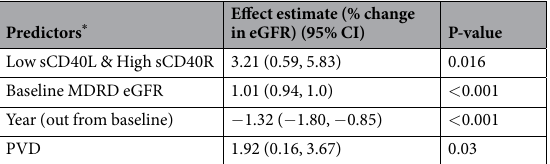
Table 3. Independent Predictors of Longitudinal Changes in eGFR. Only statistically significant predictors of longitudinal changes in eGFR (baseline out to 4 years) are included. The model was adjusted for, age, sex, baseline eGFR, systolic blood pressure (SBP), history of peripheral vascular disease (PVD) and diabetes mellitus, primary renal disease, and baseline ACEi/ARB or aspirin use. * Using High sCD40L & Low sCD40R as the reference group Abbreviations: MDRD, Modified Diet in Renal Disease study; GFR, estimated glomerular filtration rate; sCD40L, soluble CD40 ligand; sCD40R, soluble CD40 receptor; BP, blood pressure; and CI, confidence interval; and PVD, peripheral vascular